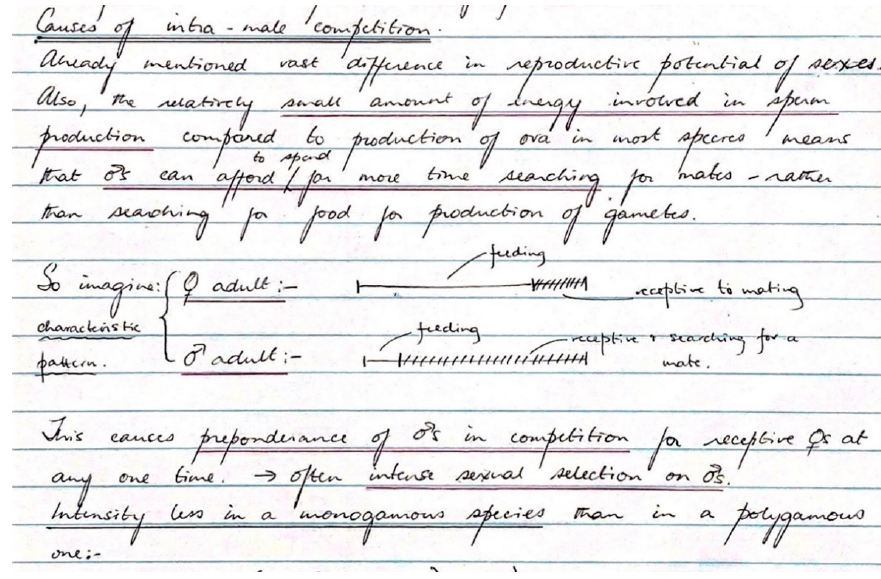
Figure 2. Inset from the first of my four lectures on sexual selection to final-year students, late 1969.